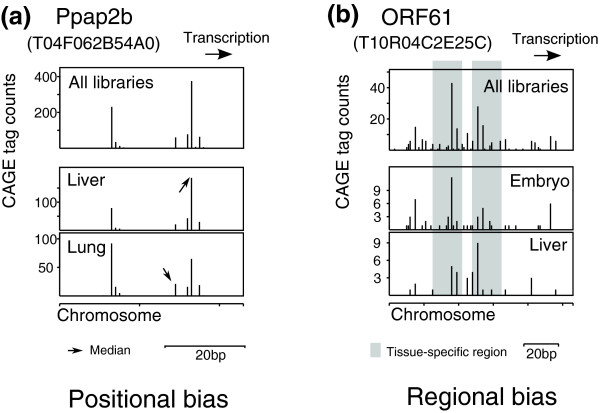
Examples of fine-grained tissue specificity. Examples of fine-grained tissue specificity are shown. (a) CAGE tag distribution of a tag cluster located at the 5' end of Ppap2b (tag cluster ID: T04F062B54A0), which is classified as positionally biased. The CAGE tag count at each nucleotide position is displayed as a vertical line. Totals of CAGE tag counts derived from all libraries are shown as all libraries, and two tissues picked from the 22 utilized tissues, liver, and lung are also shown. Arrows within the histograms indicate median locations of transcription initiation. (b) CAGE tag distribution of a tag cluster located at the 5' end of ORF61 (tag cluster ID: T10R04C2E25C), which is classified as regionally biased. The CAGE tag counts of all libraries, embryo, and liver are shown. Gray backgrounds indicate regions with different tissue specificity from the remaining part of the tag cluster. CAGE tag counts in each library and additional information for tag clusters is also accessible from the CAGE Analysis Database [39]. CAGE, cap analysis of gene expression.